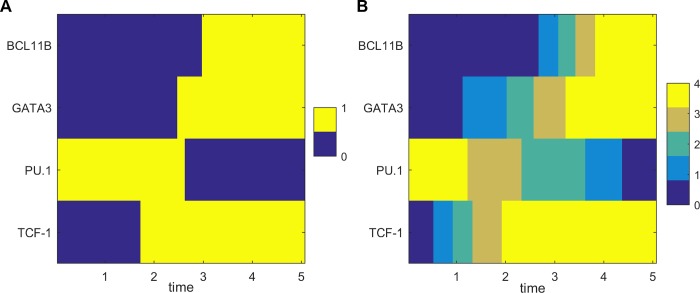
Discrete kinetic transition paths for T cell model.Transition paths from ETP state to DN3 state in terms of levels of 4 different TFs. A. The relative TF levels are discretized to 0 or 1. 1 represents that the corresponding TFs are in the on (activated) state and 0 represents that the corresponding TFs are in the off (repressed) state. B. The relative TF levels are discretized to five values from low to high. X axis shows the time along the transition path.